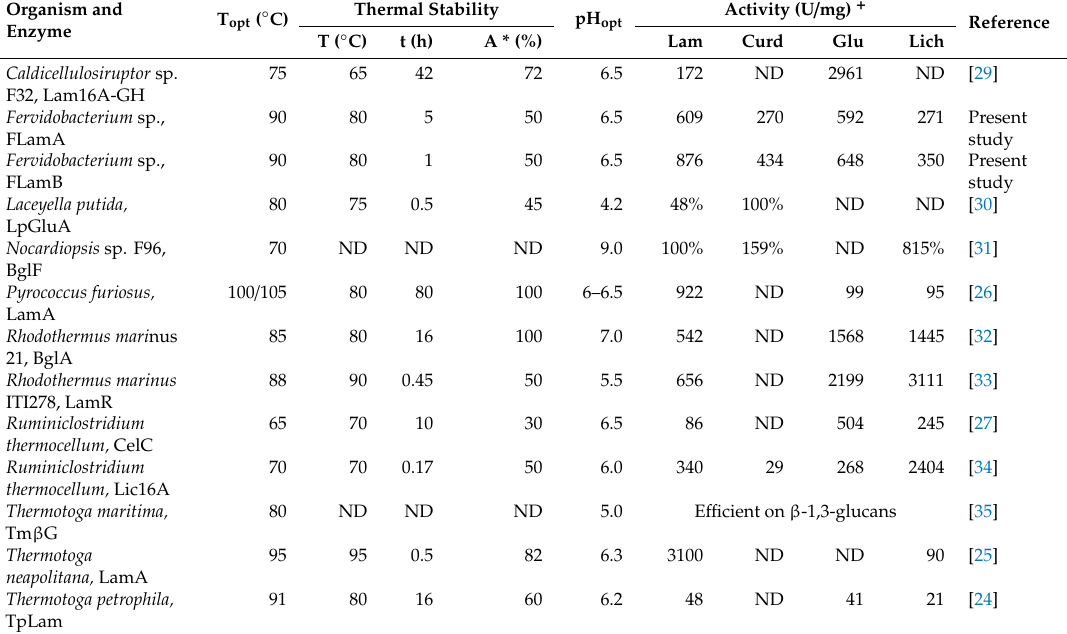
Table 3. Comparison of biochemically characterized laminarinases from thermophilic bacteria and